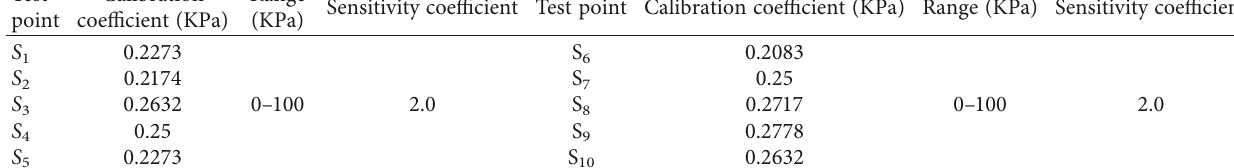
Table 5: Parameters of the soil pressure